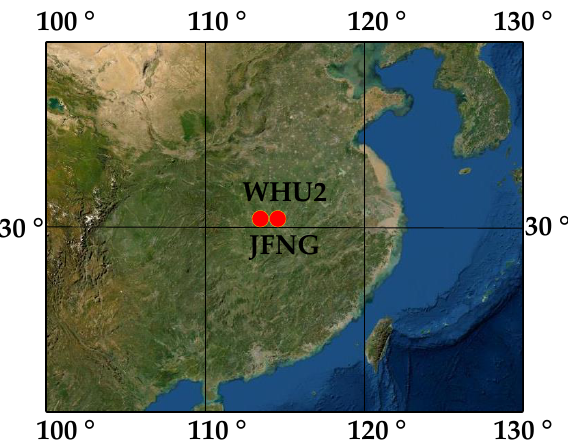
Figure 12. Position of JFNG and WHU2 stations. The PPP method with constrained coordinates was tested with the precise orbits and clock offsets of the CNES, PPP-B2b, and GBM products. Meanwhile, the CNES and GBM products were tested with quad-system (GPS/GALILEO/GLONASS/BDS) observations, and PPP-B2b products were tested with dual-system (GPS/BDS) observations. Since ordinary seismic duration is generally no more than 15 min, the constrained period of PPP processing was set to 15 min [24], which means that each station had nine sets of experiments, and each set included three different outcomes. The precise position coordinates were computed using the Natural Resources Canada online Precise Point Positioning (CSRS-PPP) tool based on four-hour observations before the reference time (https://webapp.geod.nrcan.gc.ca/, accessed on 28 October 2021). The precise coordinates were set to initial coordinates, while the displacements between the initial co- ordinates and station coordinates of subsequent epochs were calculated to evaluate the positioning performance. The detailed processing strategies are shown in Table 2. Table 2. Processing strategies. Item Processing